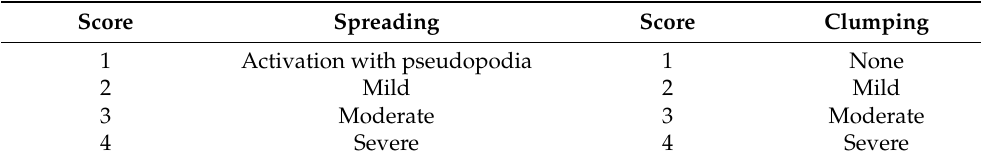
Table 3. Platelet activation criteria showing level of spreading, as well as clumping in the hemat- ocrit sample.